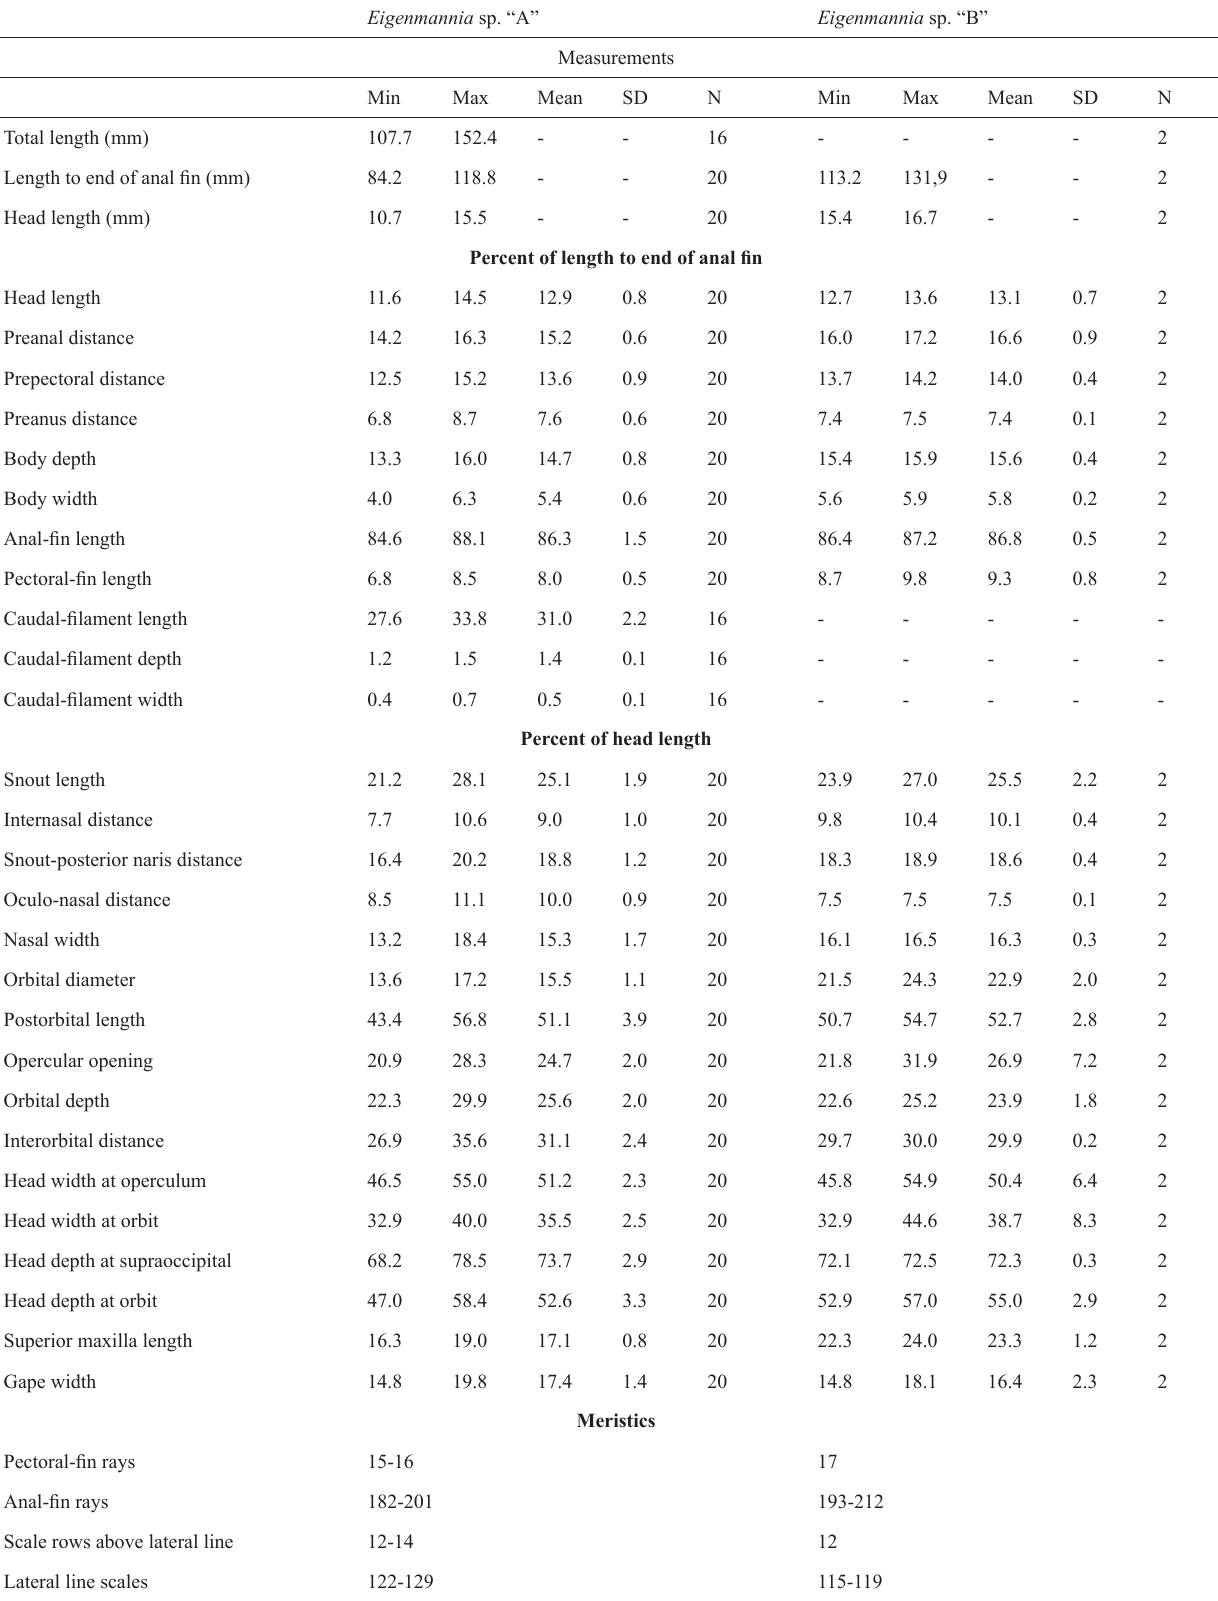
Table 3. Morphometric and meristic data for Eigenmannia sp. “A” and Eigenmannia sp. “B”. Legend: Min: Minimum; Max: Maximum; SD: Standard deviation; N: number of specimens analysed. Eigenmannia sp.